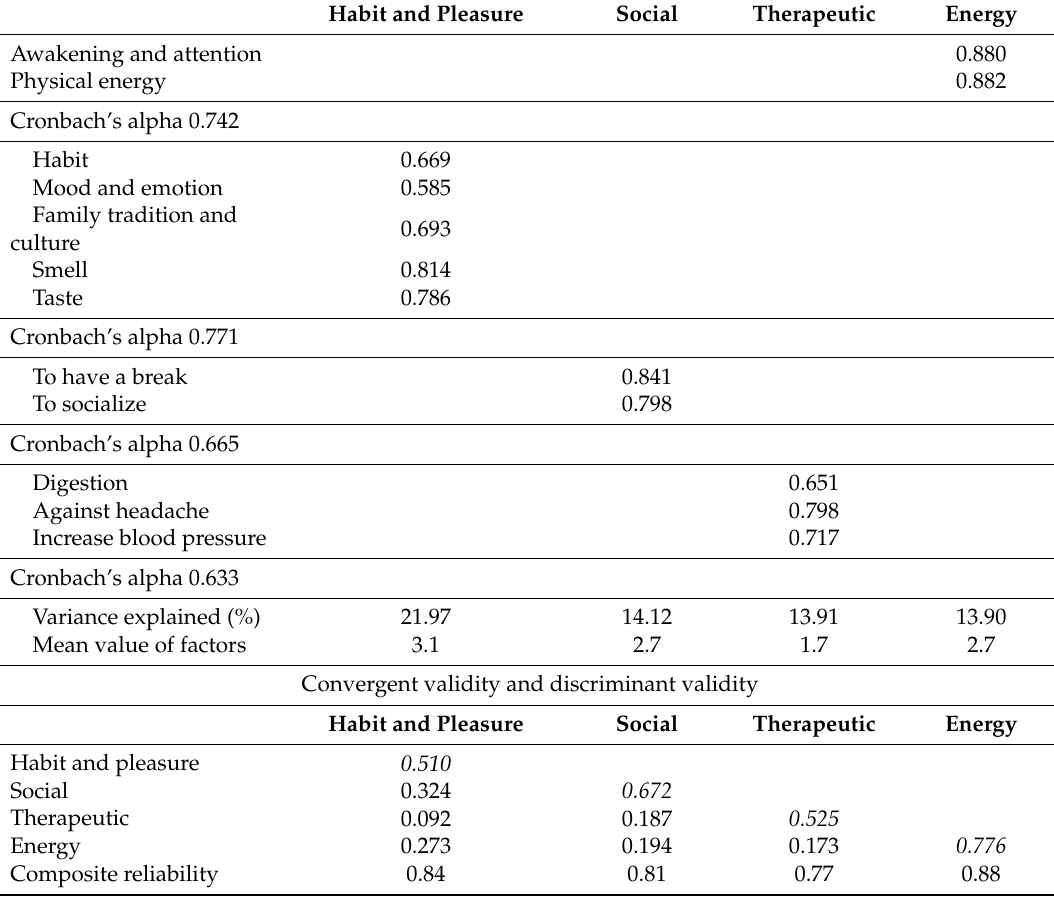
Table 5. Factor analysis on motives for coffee consumption and convergent validity and discriminant validity for each